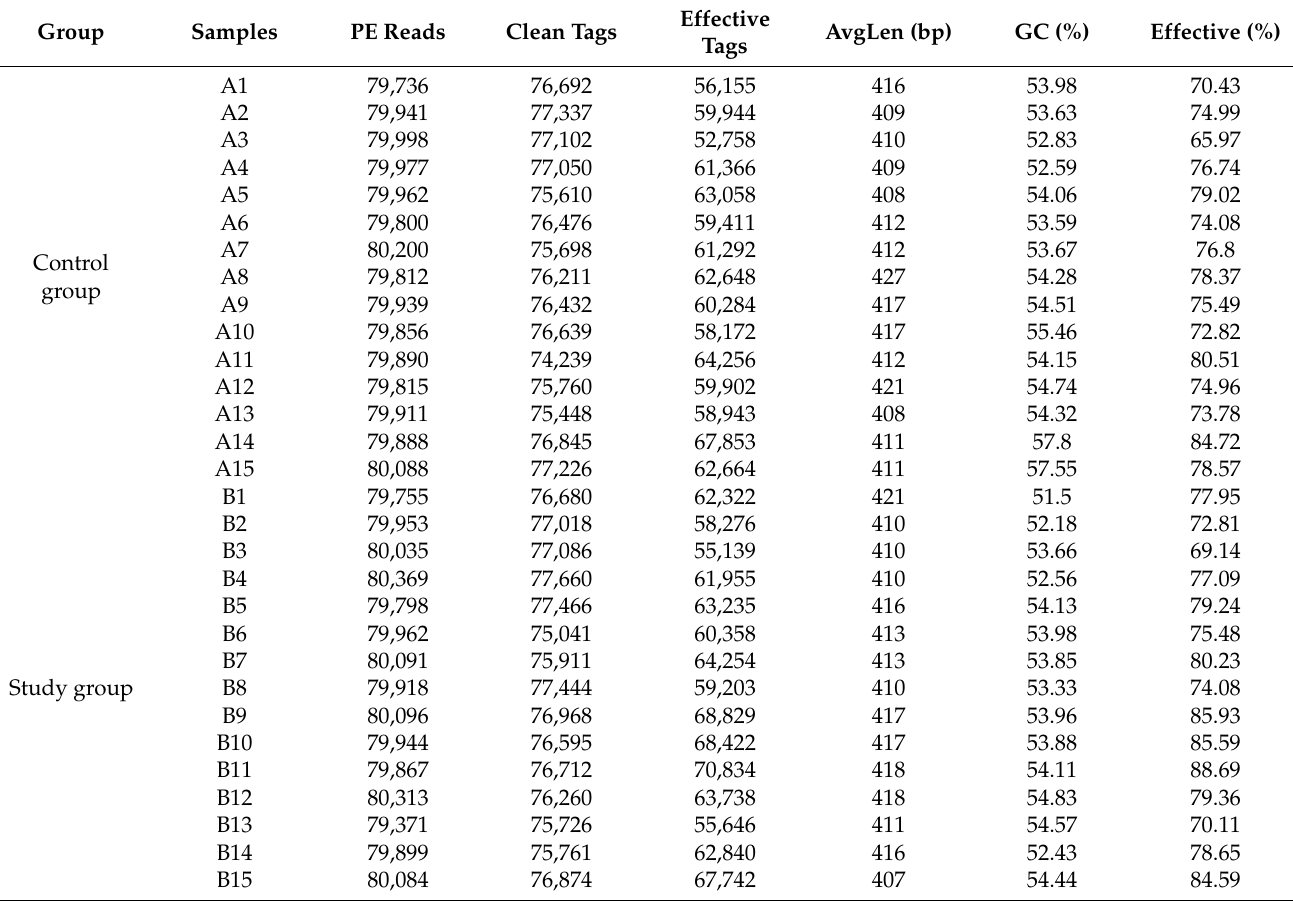
Table 5. Quality statistics of intestinal microbiological sequencing data of two